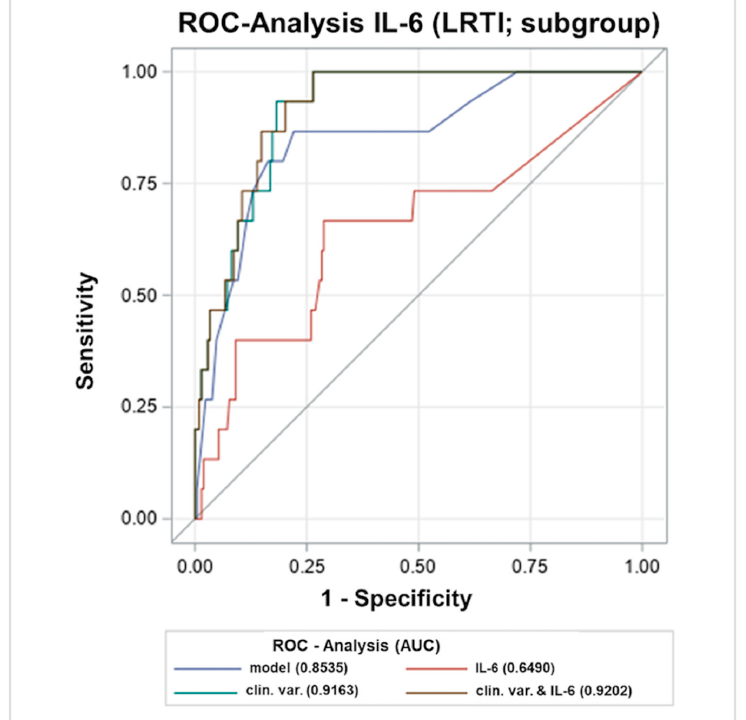
Figure 3. Receiver operating characteristic (ROC)-curves of early (<12 h) IL-6 and clinical variables in predicting LRTIs . AUC, area under the curve; IL, interleukin; LRTI, lower respiratory tract in- fection; ROC, Receiver Operating Characteristics; SAI, Stroke-associated infection; h, hours.